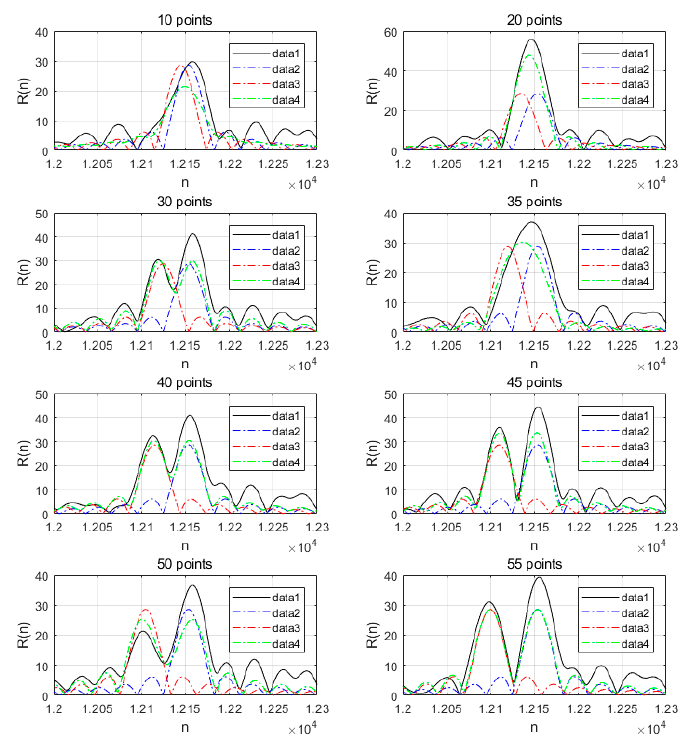
Figure 11. Two identical preamble correlations with different distance intervals.